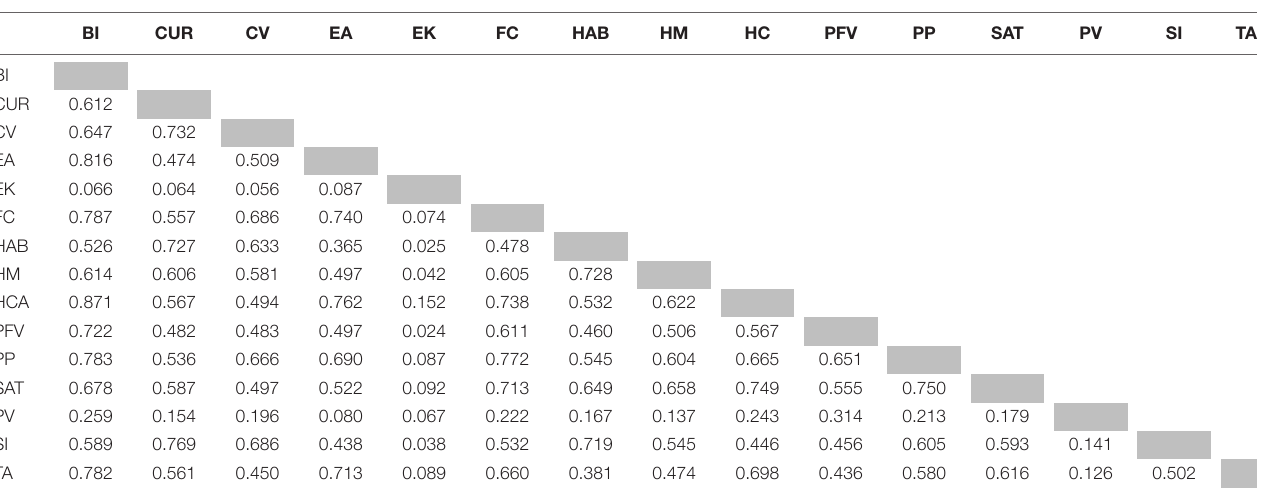
TABLE 4 | Heterotrait-Monotrait ratio